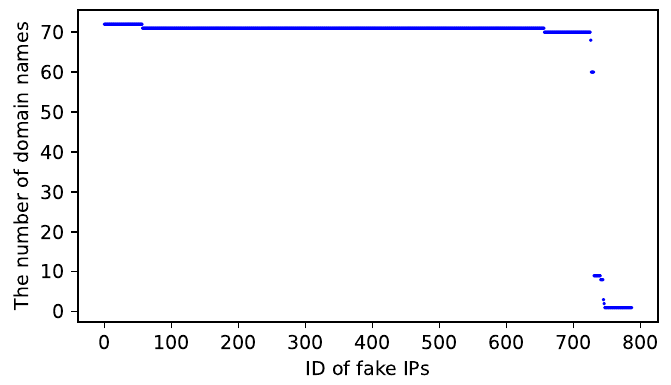
Figure 16. DNS filtering devices answer the same forged IP to different blocked domain